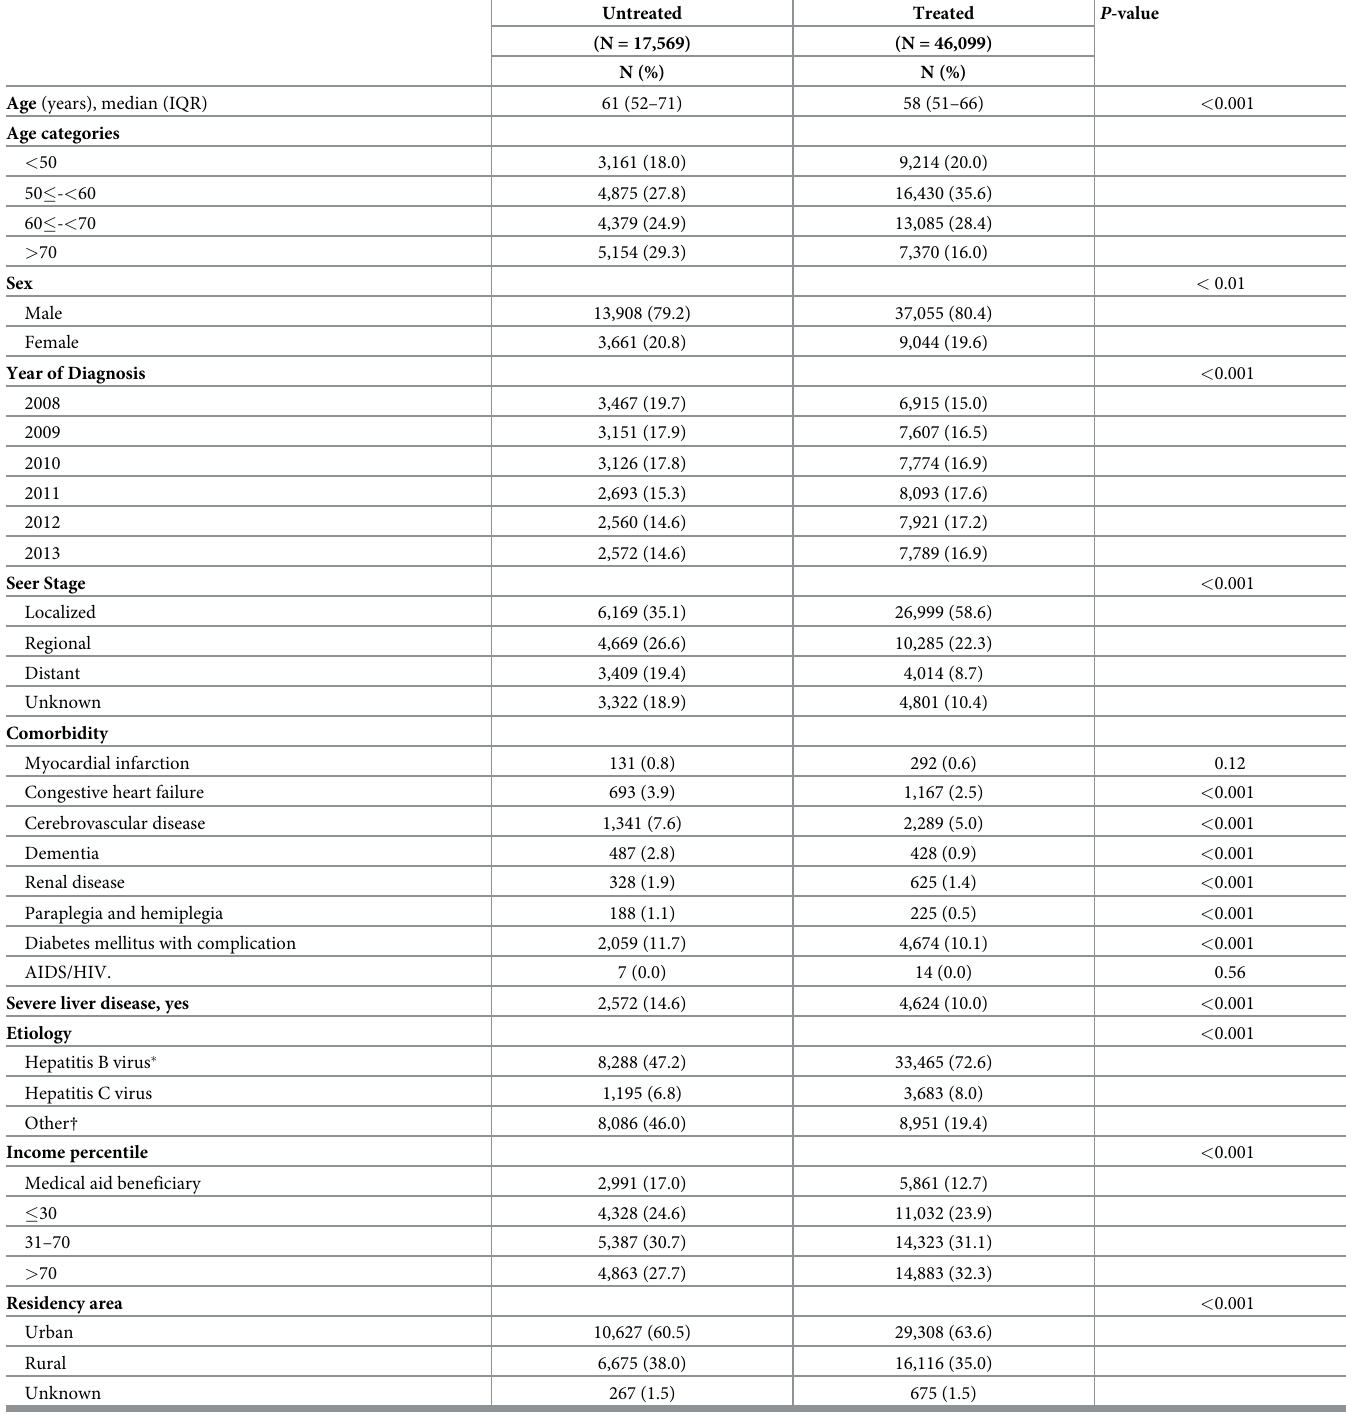
Table 1. Characteristics of study